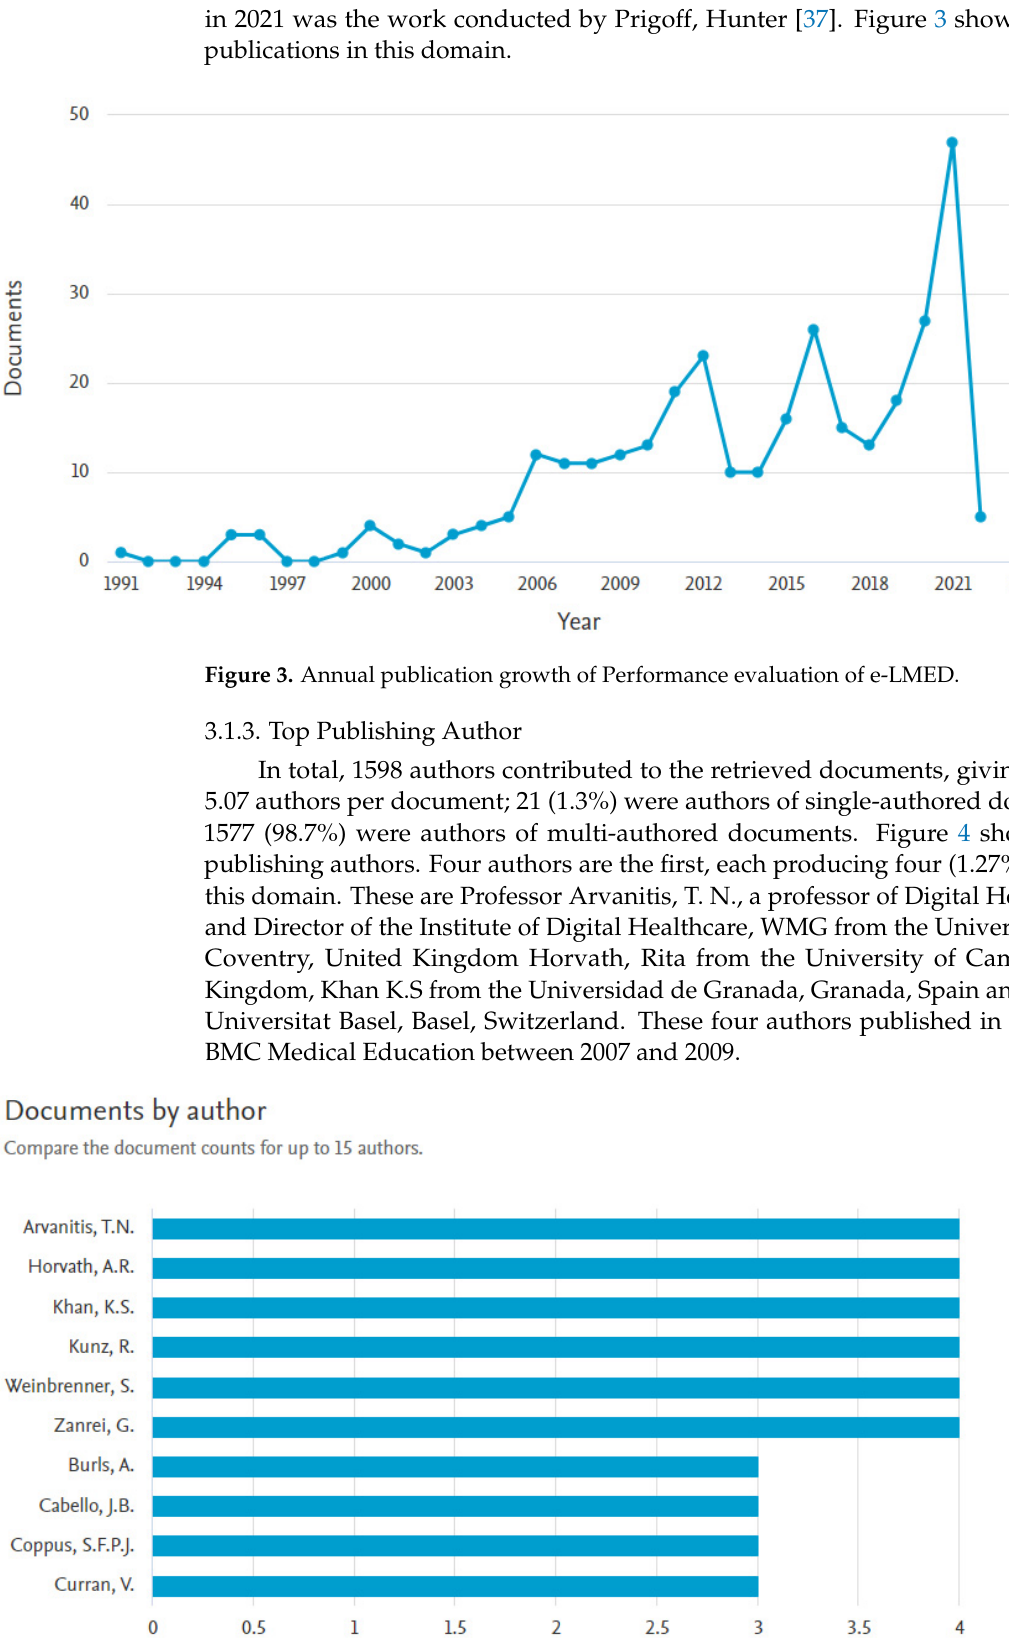
8 of 27 Figure 2. The document by Discipline. 3.1.2. Growth of Publication